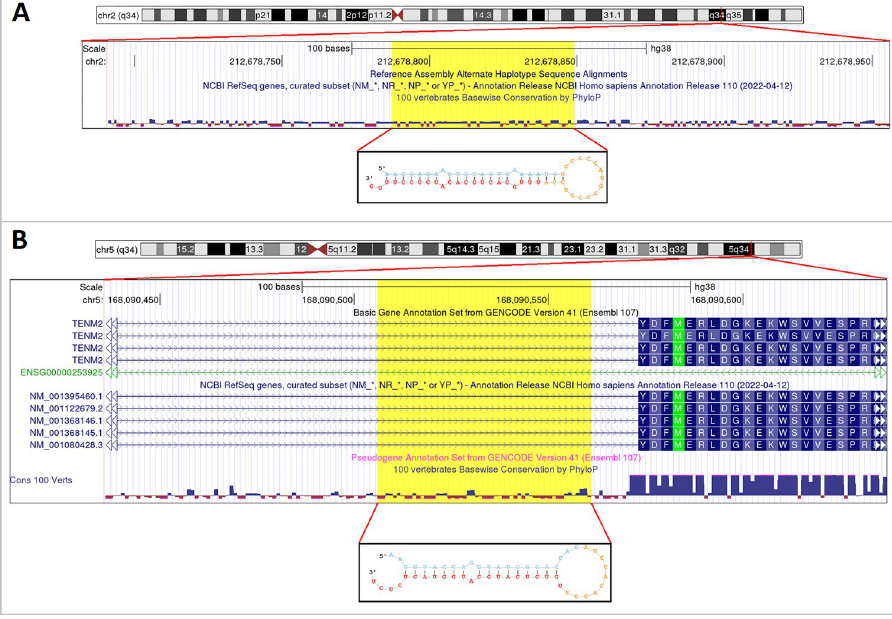
Fig 1. Representation of two confirmed novel miRNAs. Genomic position (GRCh38) and structure of confirmed novel miRNAs. A: 2_nv_chr2_212678788; B: 3_nv_chr5_168090507. Mature miRNA sequences are shown in red. https://doi.org/10.1371/journal.pone.0283186.g001 miRNAs potentially involved in cHL pathogenesis. We rejected candidates observed more fre- quently than in 2% of the NHL cohort (n = 56). Altogether, 6 novel miRNA candidates were identified and further validated experimentally. six novel miRNA candidates were confirmed to be expressed in the cHL cell lines ( Fig 1; Table 1 ). The novel miRNA (2_nv_chr2_212678788) was confirmed to be expressed by RT- qPCR in 4/7 cHL cell lines (SUP-HD1, U-HO1, L-428, L-1236) and absent in the remaining cHL and NHL cell lines in agreement with the RNA-seq data ( Fig 2A ).